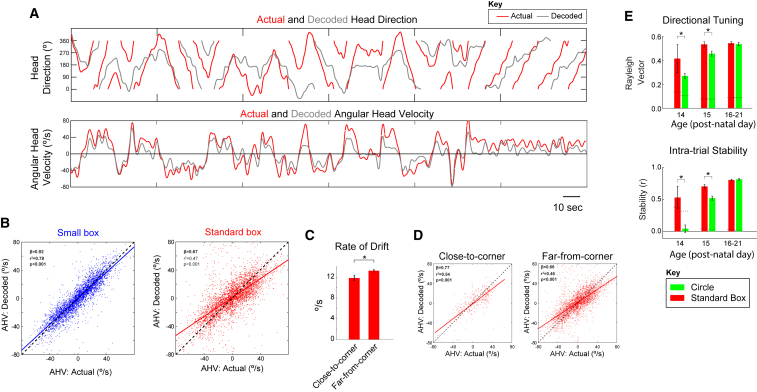
HD Drift in Young Rodents Is Caused by Angular Head Velocity Under-Signaling and Is Reduced by Proximity to Corners(A) Example of actual (red) and decoded (gray) head direction (top) and angular head velocity (bottom) values displayed by a P14 rat during 5 min exploration in the standard box. See also Figure S3.(B) Correlation between actual (x axis) and decoded (y axis) angular head velocity scores in the small (left) and standard (right) boxes across all decoded ensembles (n = 6). Slope of relationship between actual and decoded angular head velocity is significantly smaller in the standard versus small box.(C) Mean (±SEM) rate of drift (rate of divergence between actual and decoded head direction) when rats were close or far from the corners of the standard box.(D) Angular head velocity under-signaling is reduced when rats are close to corners. Correlations are shown between actual and decoded angular head velocity scores in the standard box, split by proximity to corners (left, close; right, far). See also Figure S4.(E) Directional tuning and intra-trial stability of HD cells are reduced in a circular environment, as compared to the standard (square) box, on P14–P15. Bar charts show the mean (±SEM) Rayleigh vector (top) or intra-trial stability (bottom) of HD cells recorded in standard and circular environments.